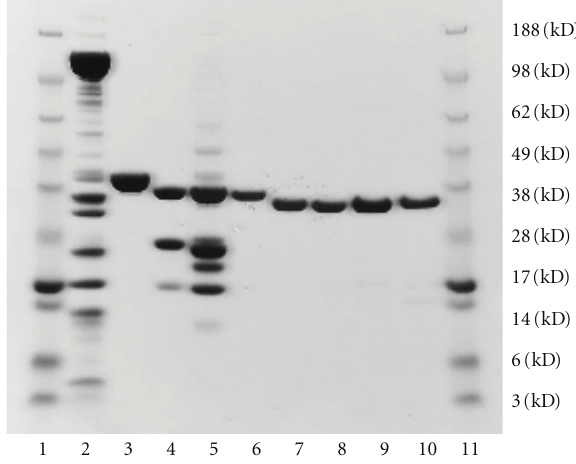
Figure 1: SDS-PAGE analysis of representative protein prepara- tions. Gel was 4–12% polyacrylamide gradient (Invitrogen) and was stained with Coomassie brilliant blue. Lanes 1 and 11: MW markers (Invitrogen See Blue Plus 2; MWs given at right). Lane 2: rabbit skeletal muscle HMM. Lane 3: rabbit skeletal muscle actin. Lane 4: recombinant rat cardiac troponin (for reference